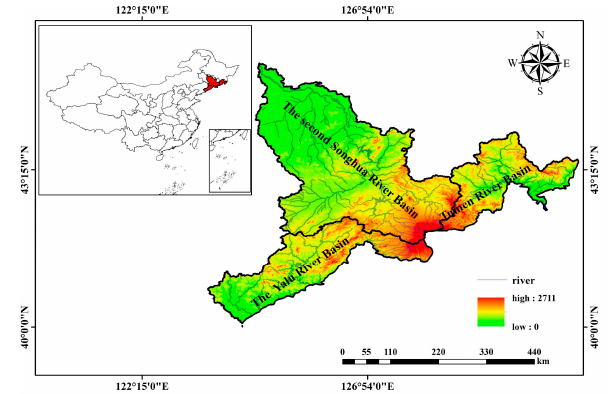
Figure 1. Study Figure 1. Study area. Table 1. Spectral bands for the JL-1 satellite.